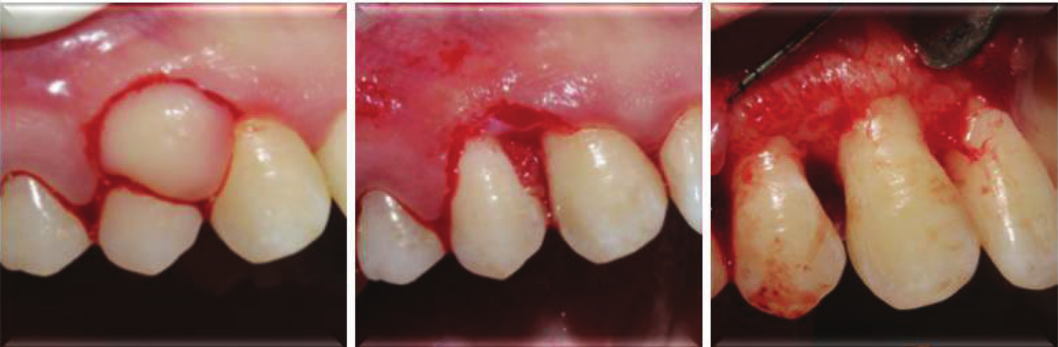
Figure 3: Excision of the lesion and flap operation of the site.